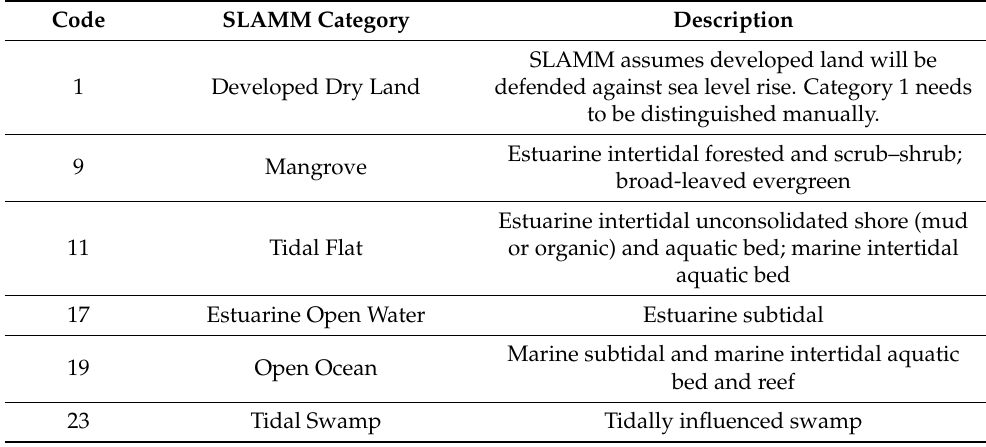
Table 1. Description of the study areas with their equivalent SLAMM